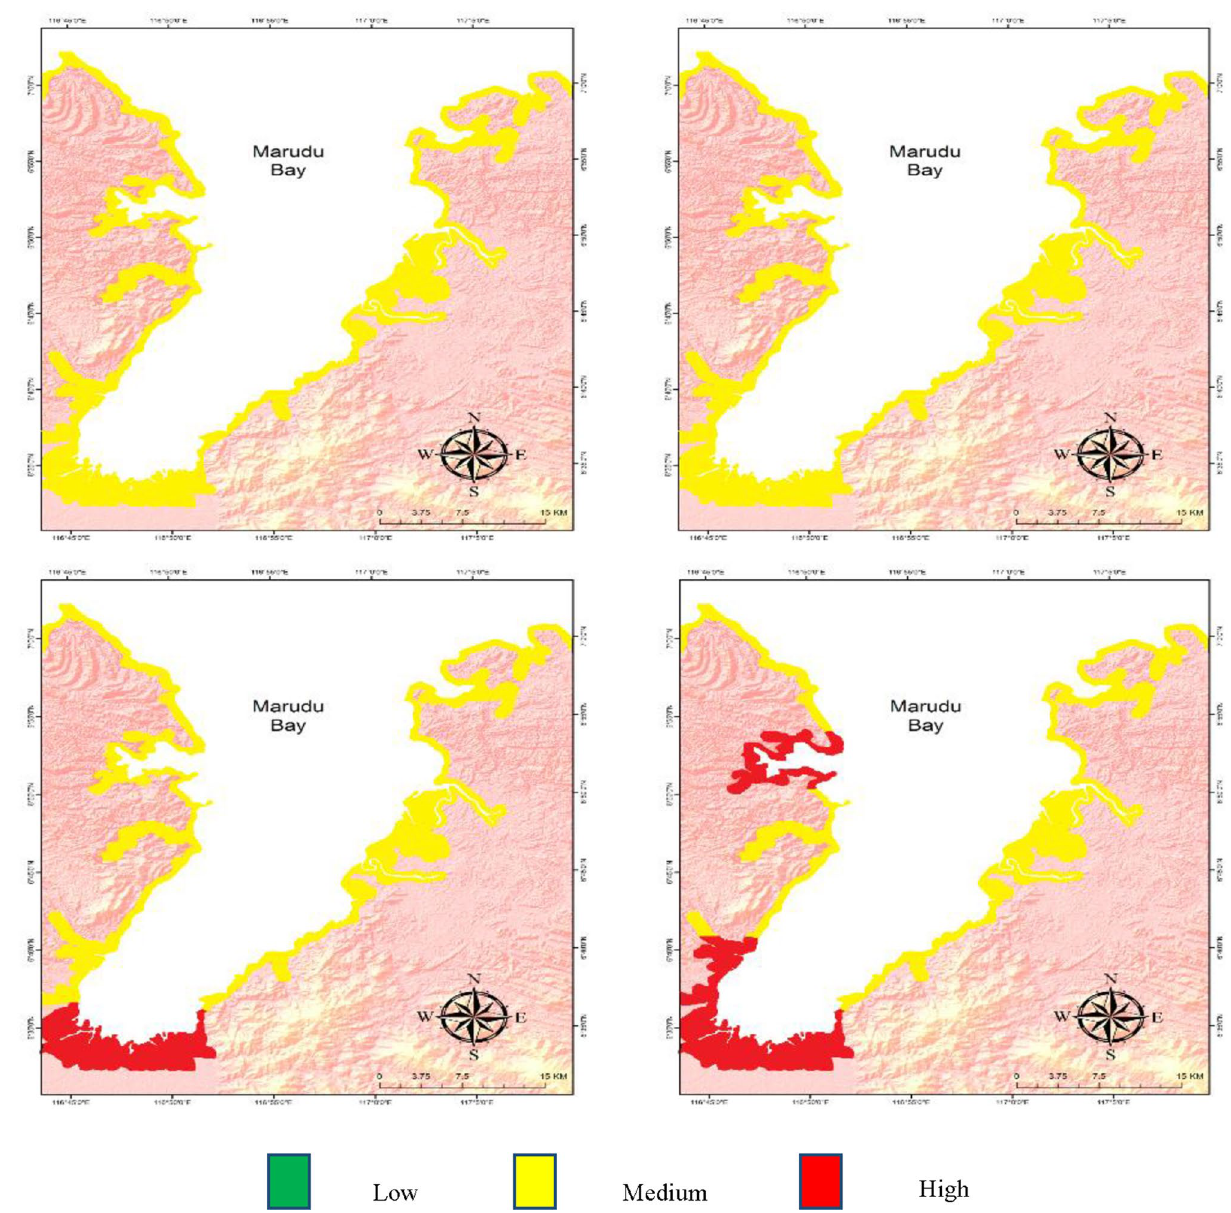
Fig. 9 CCVI for coastal Marudu bay at 2050 (left panel) and 2100 (right panel) during winter monsoon (top panel) and summer monsoon (bottom panel) under RCP 8.5 climate change